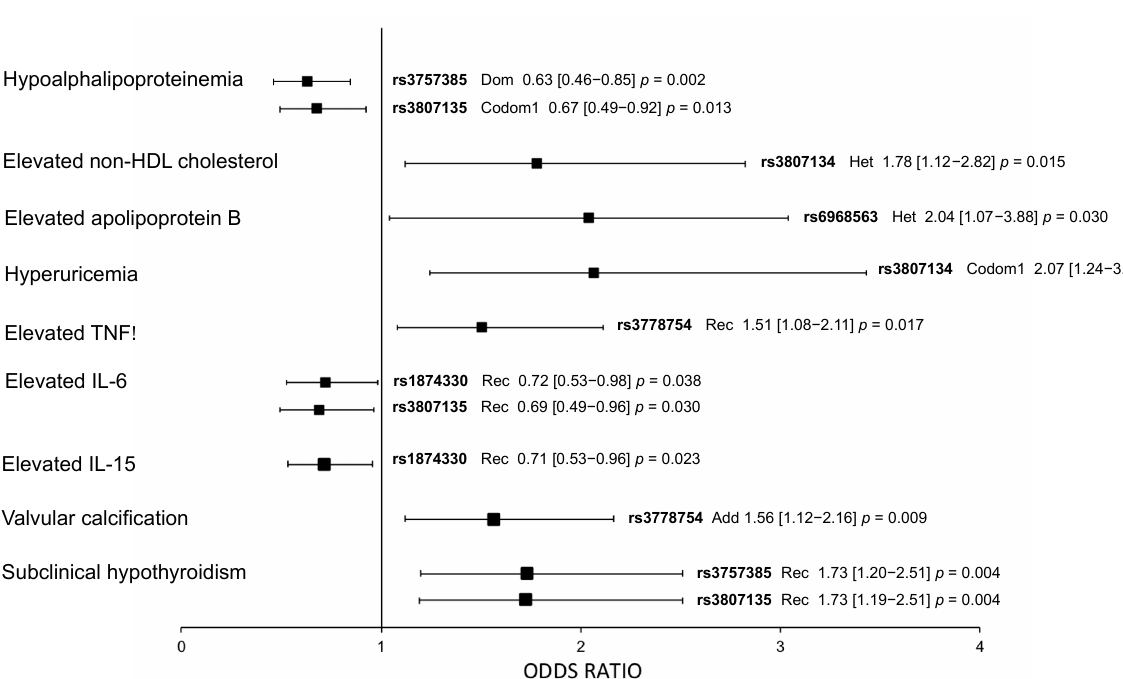
Figure 1. Association of IRF5 polymorphisms with cardiometabolic parameters in healthy controls. All models were adjusted by age, sex, and BMI. Dom: dominant model; Rec: recessive model; Codom1: codominant 1 model; Het: heterozygote model; Add: additive model. OR (95% CI) p values.